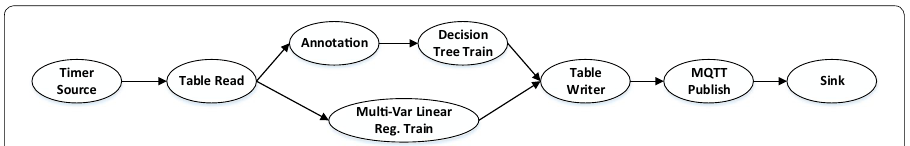
Fig. 10 Layout of Model Training